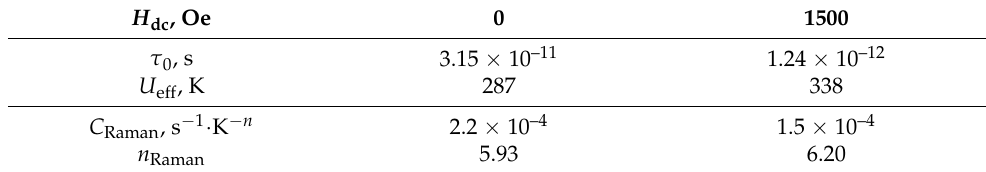
Figure 5. The ln(τ) vs. 1/T dependencies for complex 1 at zero and 1500 Oe dc field. Dots are experimental data; lines are fits with Equation (1). Table 1. Best-fit parameters with Equation (1) for the magnetic relaxation time for complex 1 .